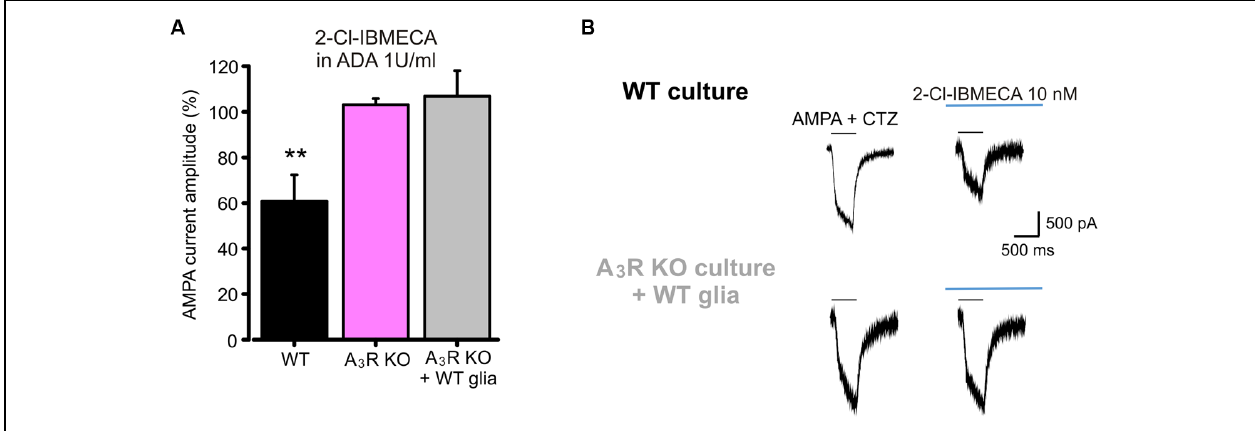
FIGURE 3 | AMPARs function modulation requires neuronal A 3 R activation. (A) Reduction of AMPA current amplitude induced by the application of A 3 R agonist 2-Cl-IBMECA in cultured hippocampal neurons treated with Adenosine deaminase (1 U/ml, 1 h preincubation + perfusion); bar chart representing the effect observed in WT cultures (black; n = 12); or A 3 R KO cultures (magenta; n = 13); gray column represents the effect of 2-Cl-IBMECA in A 3 R KO cultures in the presence of WT glial cells ( n = 12). (B) Sample traces showing the effect of 2-Cl-IBMECA on AMPA currents in hippocampal neurons from WT (top) and A 3 R KO (bottom) mice, co-cultured with WT glial cells. ∗∗ p <